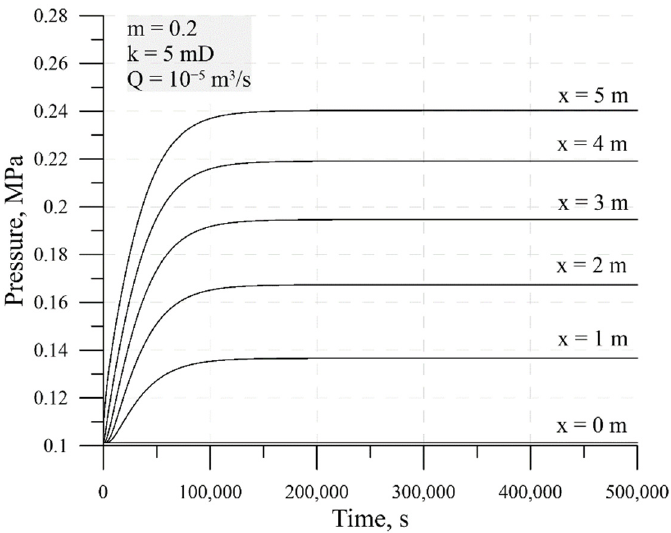
Figure 1. Time-dependent pressure variations at depths from 0 to 5 m.